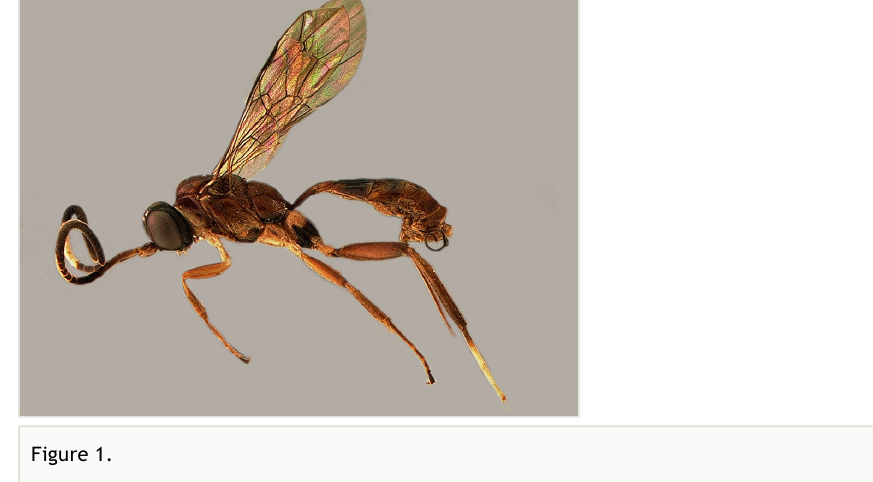
Female Trihapsis polita Townes,